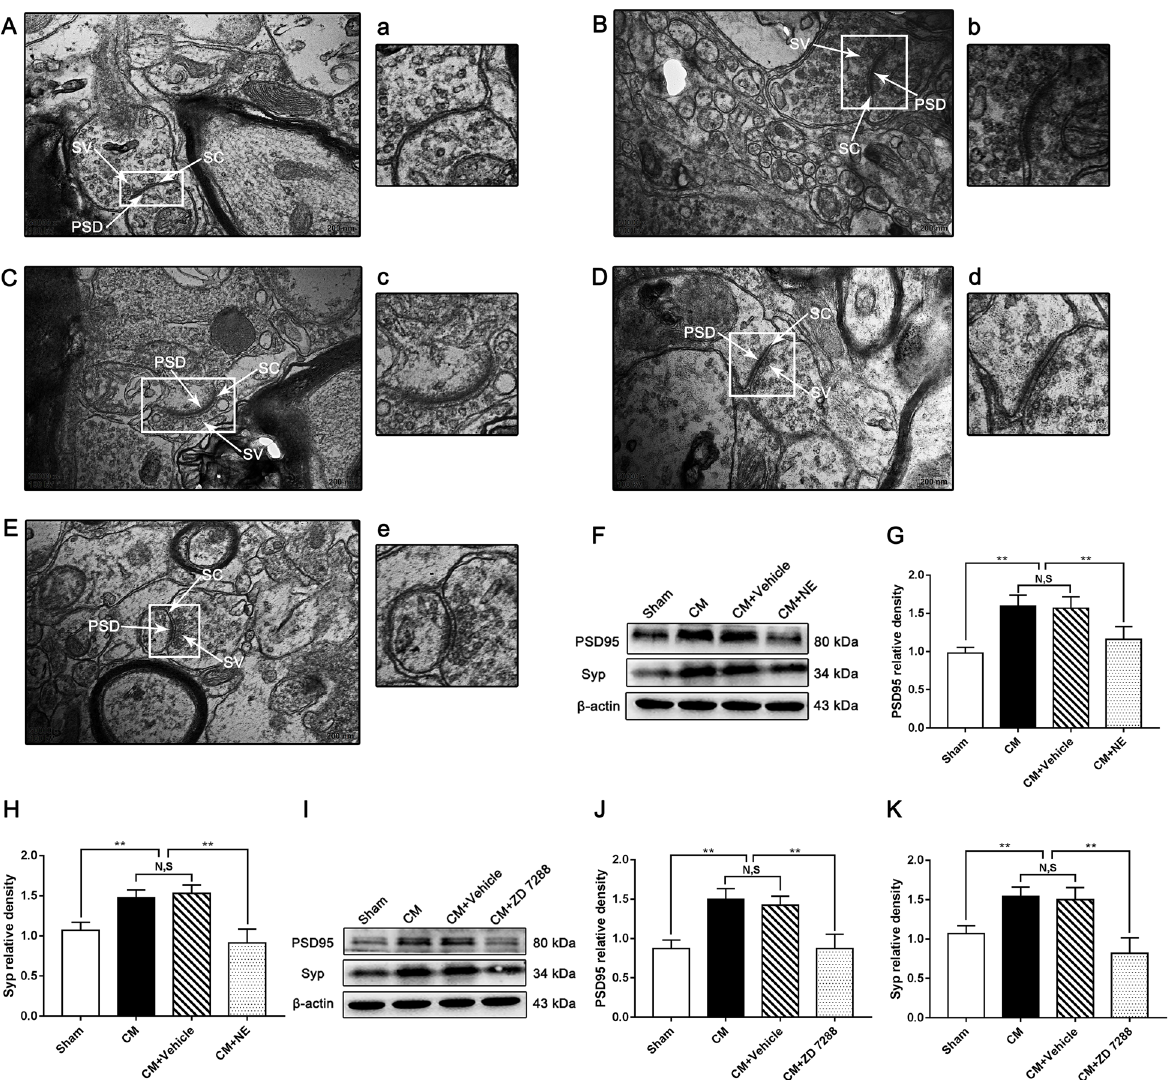
200 nm). F and I Representative western blots of PSD95 and Syp. G and H The protein = levels of PSD95 and Syp in the CM group were drastically higher than those in the Sham group, and there was no significant difference between